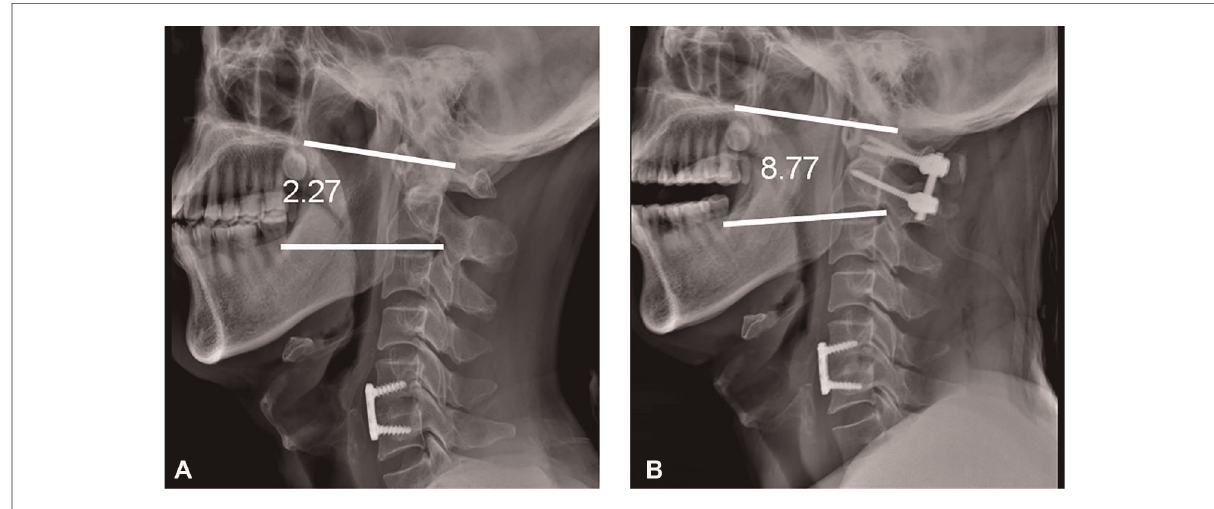
FIGURE 4 A case of postoperative dysphagia. ( A ) The preoperative C02cobb was 2.27°. ( B ) The postoperative C02cobb was 8.77°. dC02cobb was